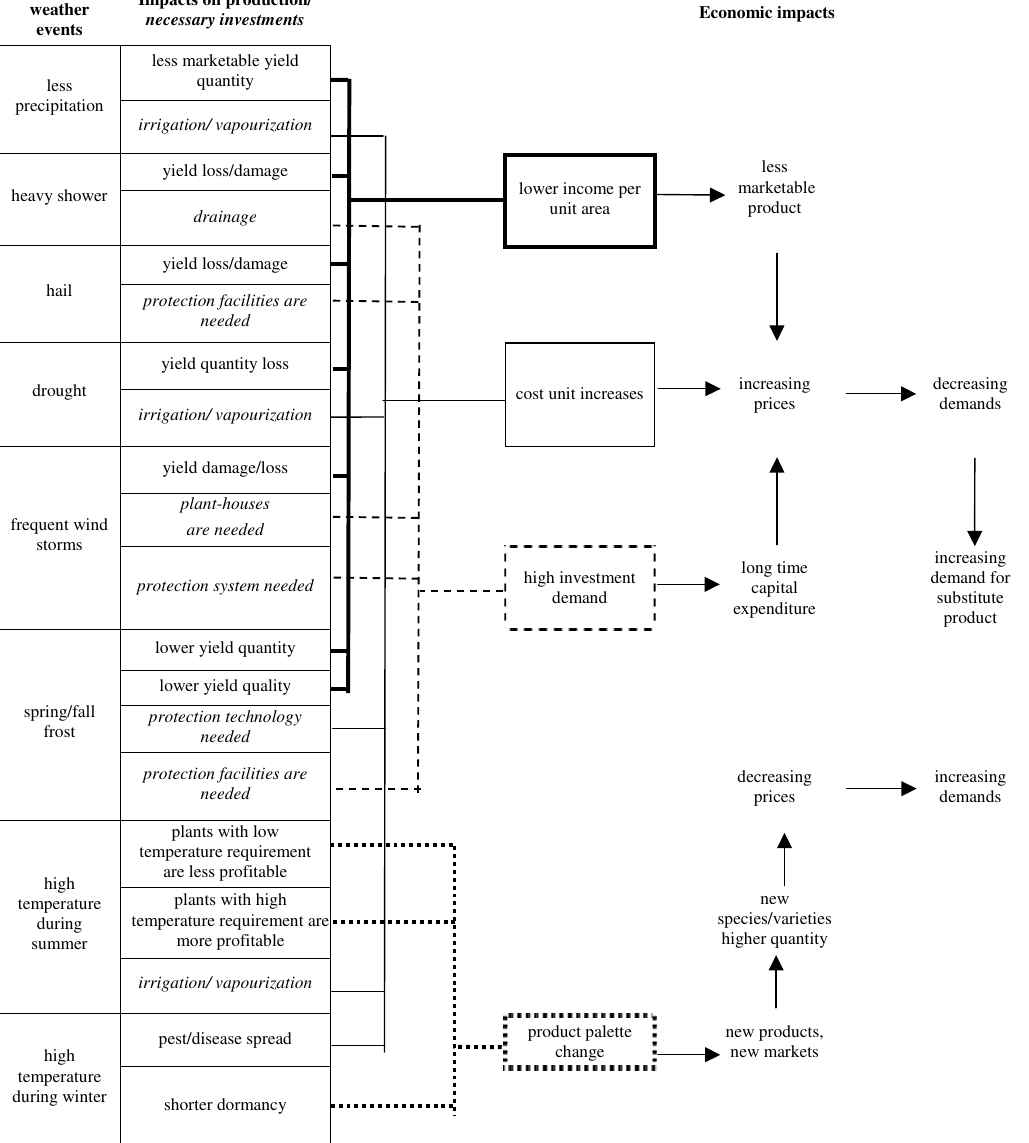
Figure 1 . Climatic risk factors and their economic